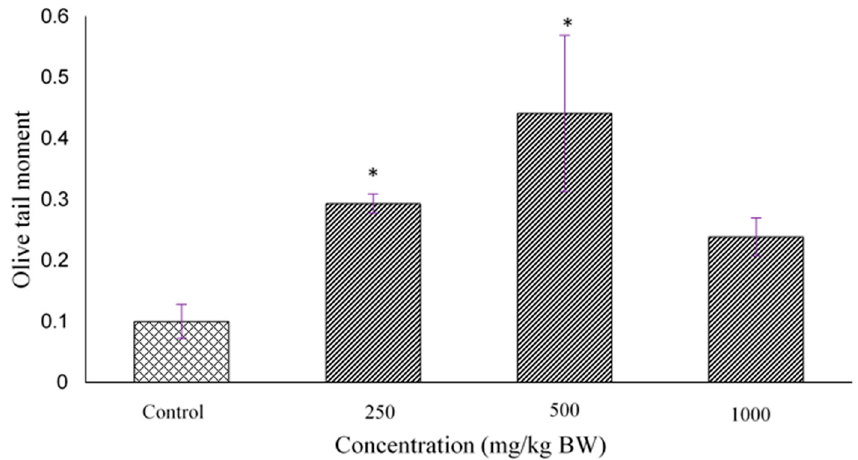
Figure 5. The chart above shows the olive moment values of DNA damage. The pregnant rats were treated with D. hispida aqueous extract at 250, 500 and 1000 mg/kg BW for 15 days. Tissues were subjected to alkaline comet assay and visualized under confocal laser microscope after staining with vista green. All the data were analyzed for tail DNA percentage and tail moment length by OpenComet v1.3.1 using ImageJ version 1.53. Values were expressed as mean ± SEM ( n = 5). * Indicates significant difference compared with control ( p < 0.05).